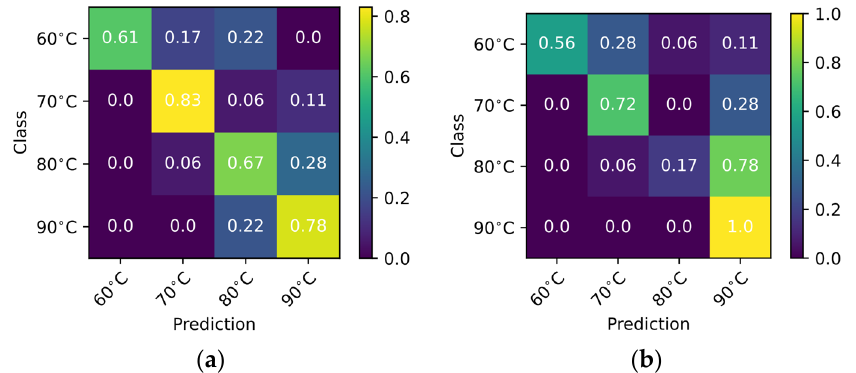
Figure 8. Confusion matrix of the MobileNet model for greyscale ( a ) and RGB color space ( b ) calculated from the validation set.